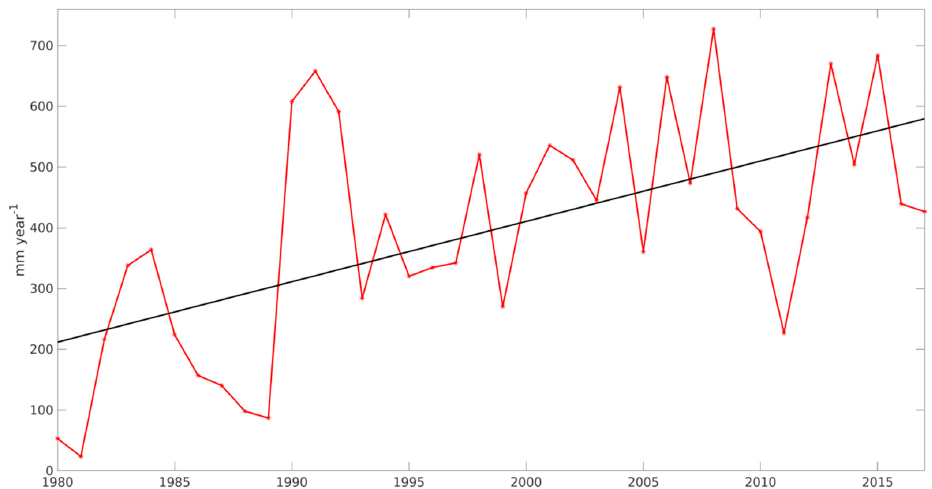
Figure 7. Example of time series at Rancho Seco ( p ≤ 0.05) weather station.